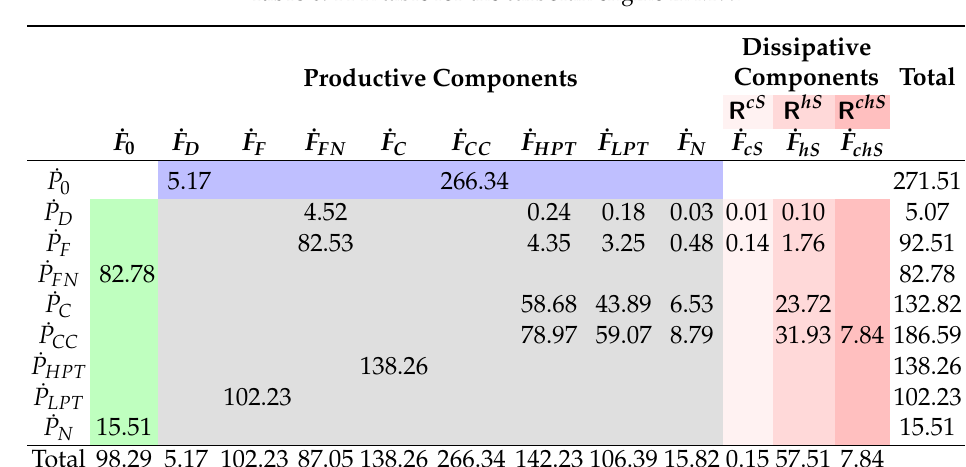
Table 6. FPR table for the turbofan engine in MW.